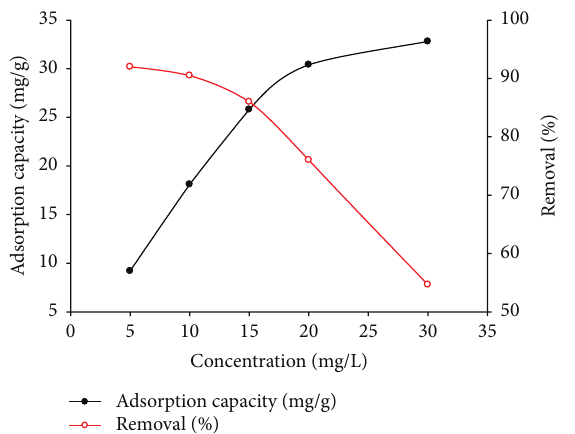
Figure 8: Effect of the concentration on the adsorption of copper by CaHBSW.